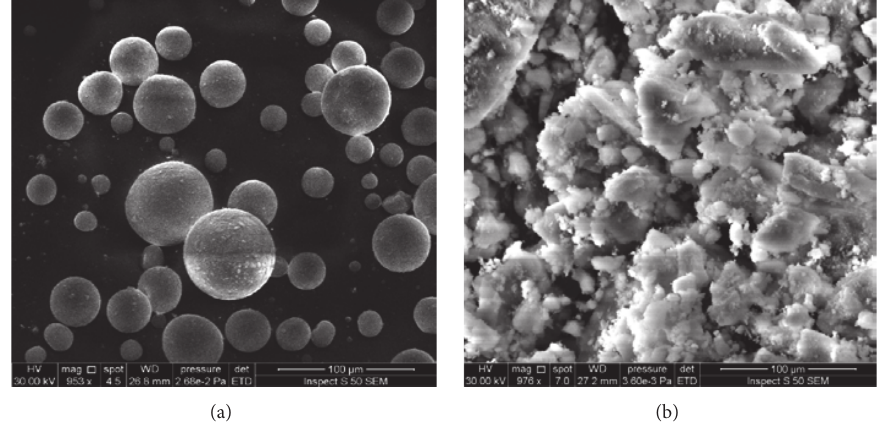
Figure 4: SEM images of (a) 𝛾 -alumina and (b) DNPH- 𝛾 -alumina.